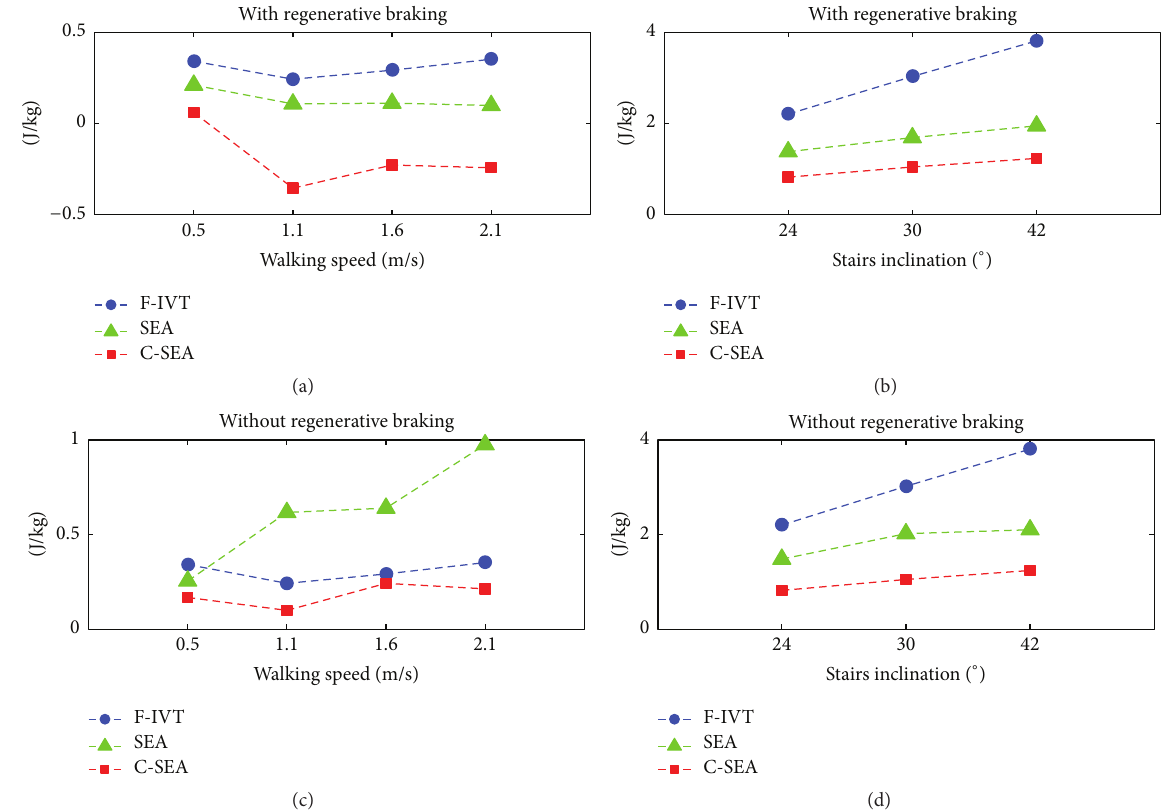
Figure 7: Motor electric energy requirement of the actuators compared (F-IVT, SEA, and C-SEA) in level ground walking at different speeds (a, c) and in stairs climbing at different inclinations (b, d), under the assumptions of regenerative braking admitted (a, b) and not admitted (c, d).